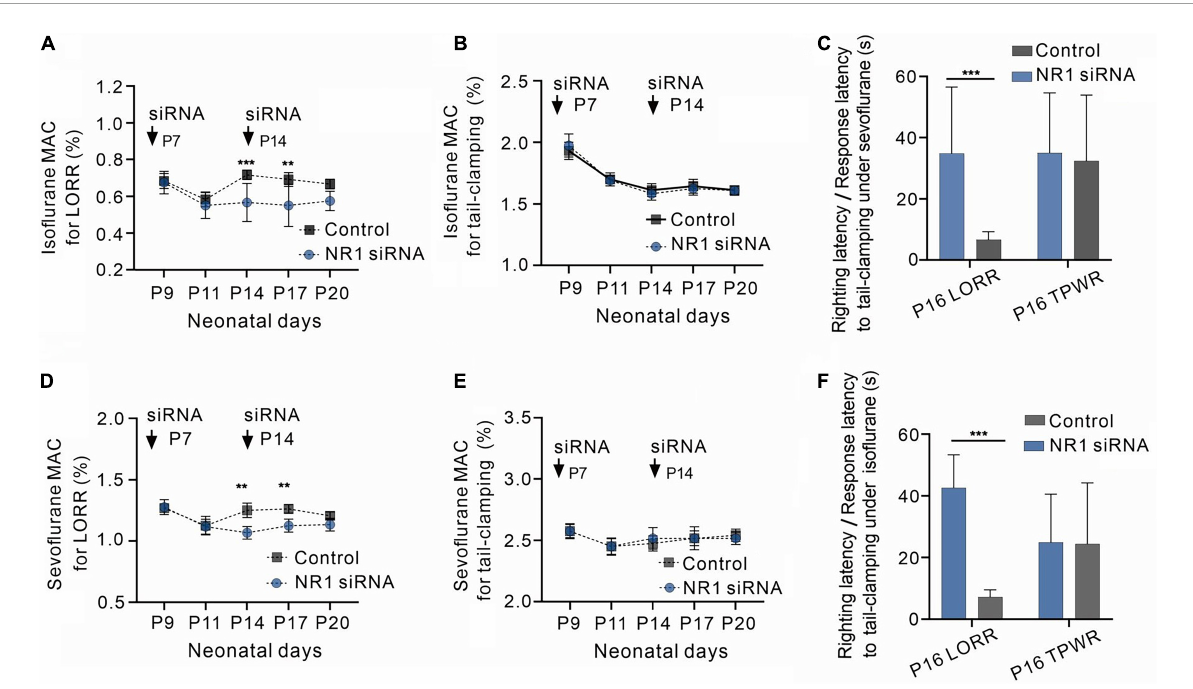
FIGURE2 Increased sensitivity to volatile anesthetics in NR1 knockdown rats for the loss of righting reflex and unchanged sensitivity of NR1 knockdown rats for anesthetic-induced immobilization. (A) Effects of NR1-siRNA on MAC LORR of isoflurane in rats at various postnatal ages ( n = 6). (B) Effects of NR1-siRNA on MAC immobility of isoflurane in rats at different postnatal ages ( n = 6). (C) Time for the recovery from loss of righting reflex (LORR) and the movement to tail-clamp reflex under isoflurane in P16 rats (left panel, 0.4% isoflurane, n = 6; right panel, 1.4% isoflurane, n = 6). (D) Effects of NR1-siRNA on MAC LORR of sevoflurane in rats at distinct postnatal ages ( n = 6). (E) Effects of NR1-siRNA on MAC immobility of sevoflurane in rats at different postnatal ages ( n = 6). (C) Time for the recovery from loss of righting reflex (LORR) and the movement to tail-clamp reflex under sevoflurane in P16 rats (left panel, 1.0% sevoflurane, n = 6; right panel, 2.3% sevoflurane, n = 6). Data are presented as mean ± SD. ** P < 0.01; *** P < 0.001 by two-way ANOVA (A,B,D,E) and unpaired t -test (C,F) .